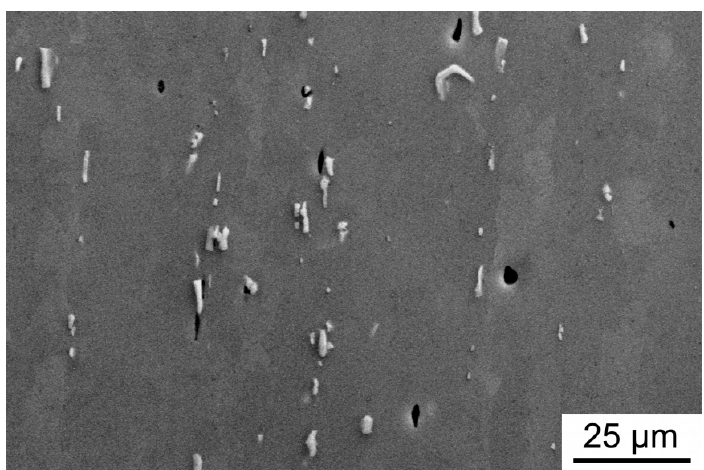
Figure 5. Intermetallic phase and precipitates in the cast homogenized rod.